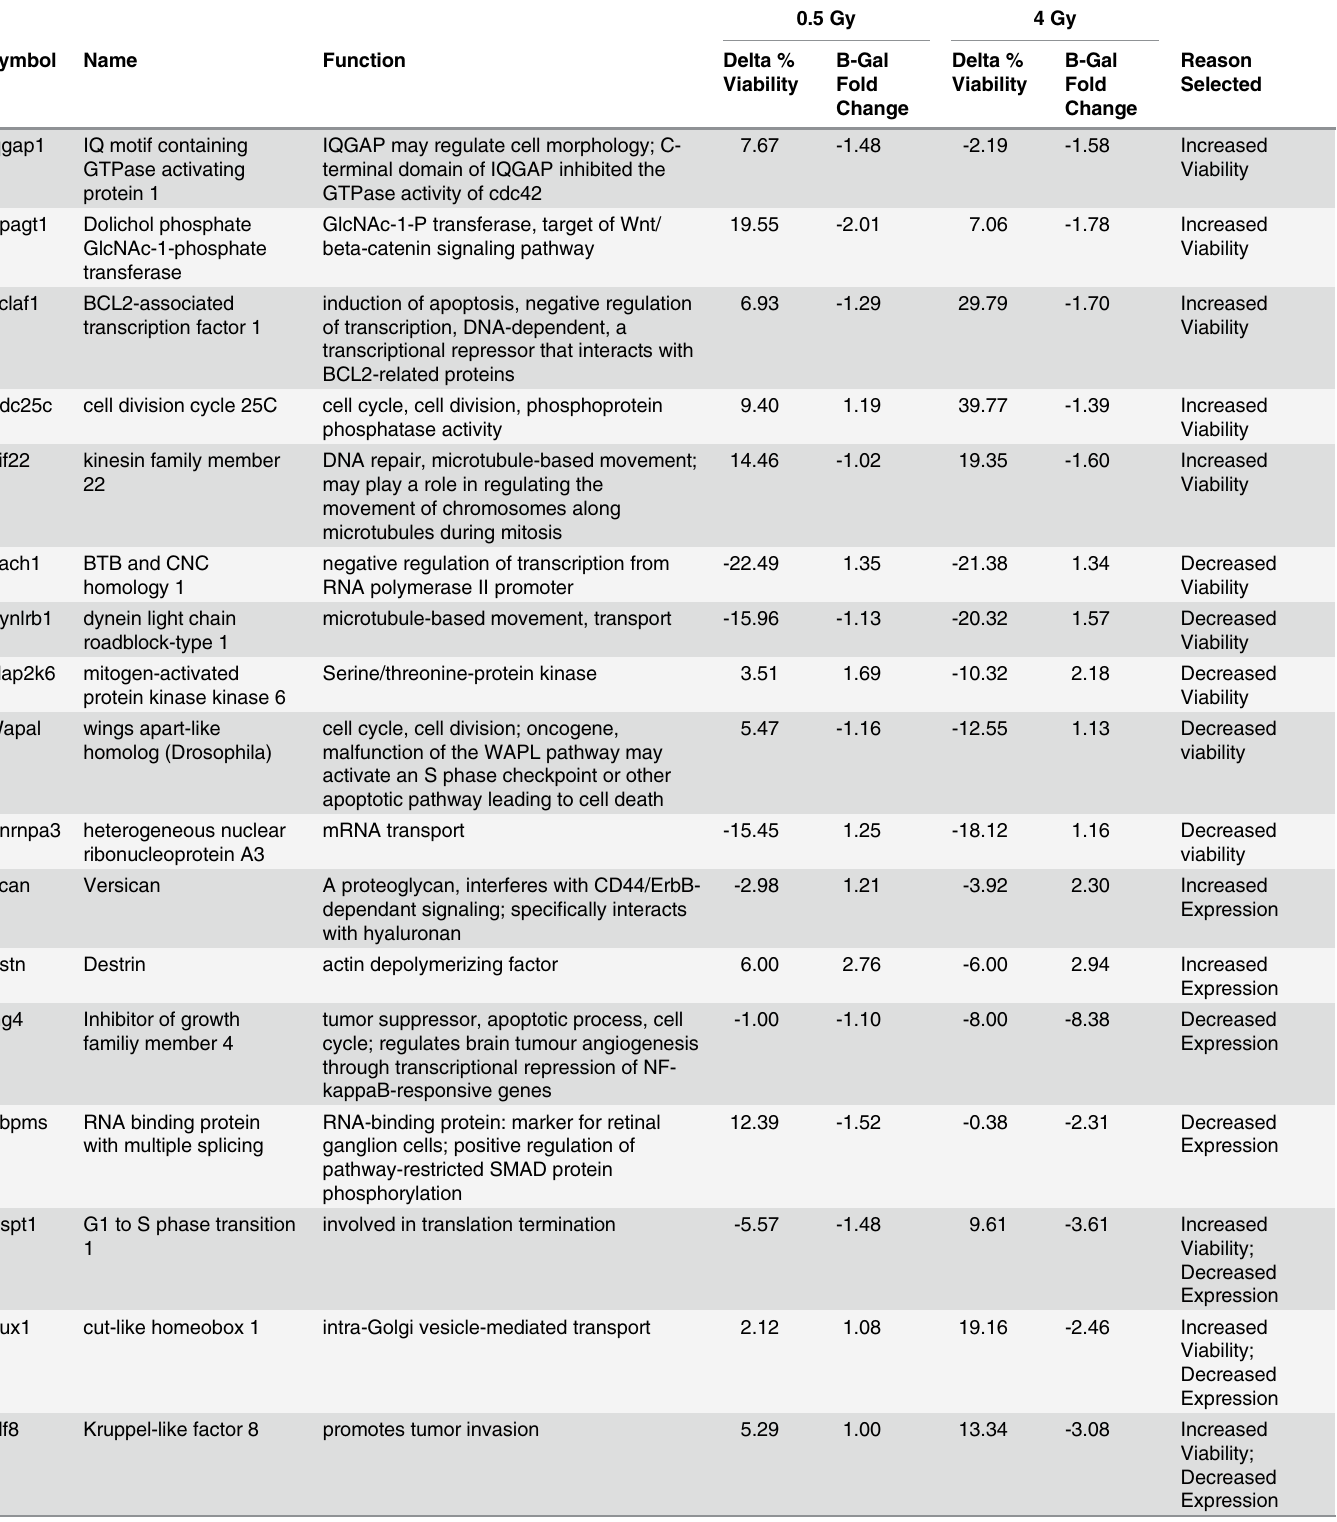
Table 4. Selected radiation response